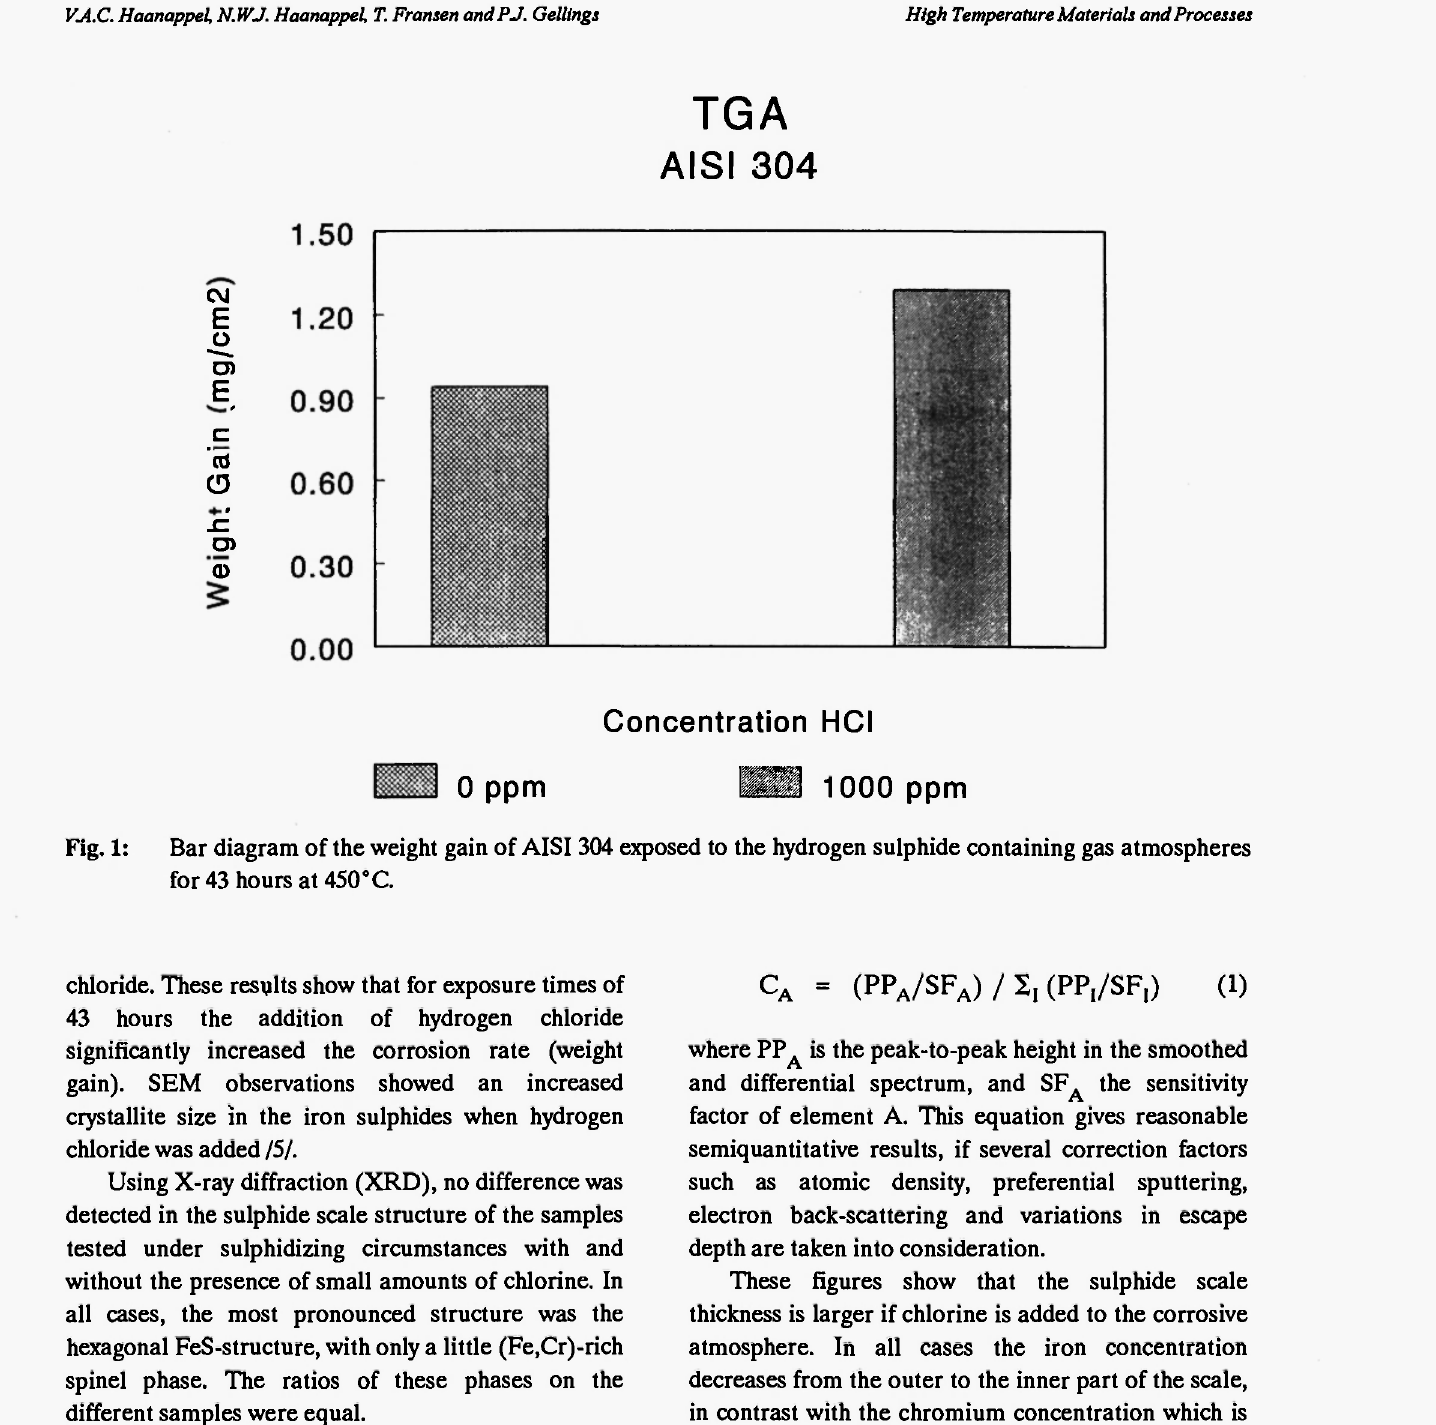
Fig. 1: Bar diagram of the weight gain of AISI 304 exposed to the hydrogen sulphide containing gas atmospheres for 43 hours at